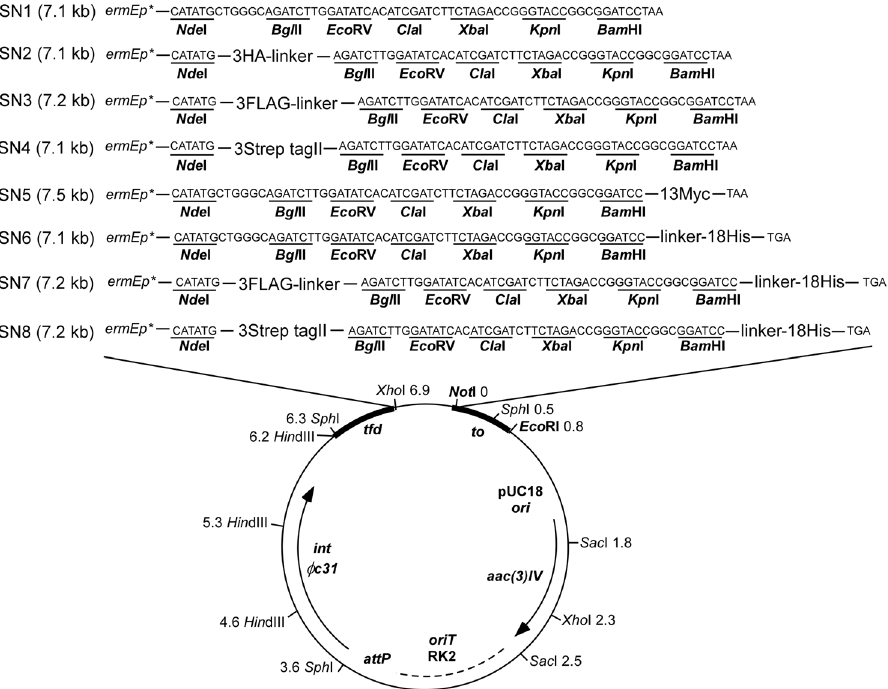
Figure 1. Maps of series of vectors pSN1-pSN8 with affinity tags. These vectors were the derivatives of pIJ8660. All the expression cassettes were driven from a strong promoter ermEp * , and multiple cloning sites (MCS) were shown in